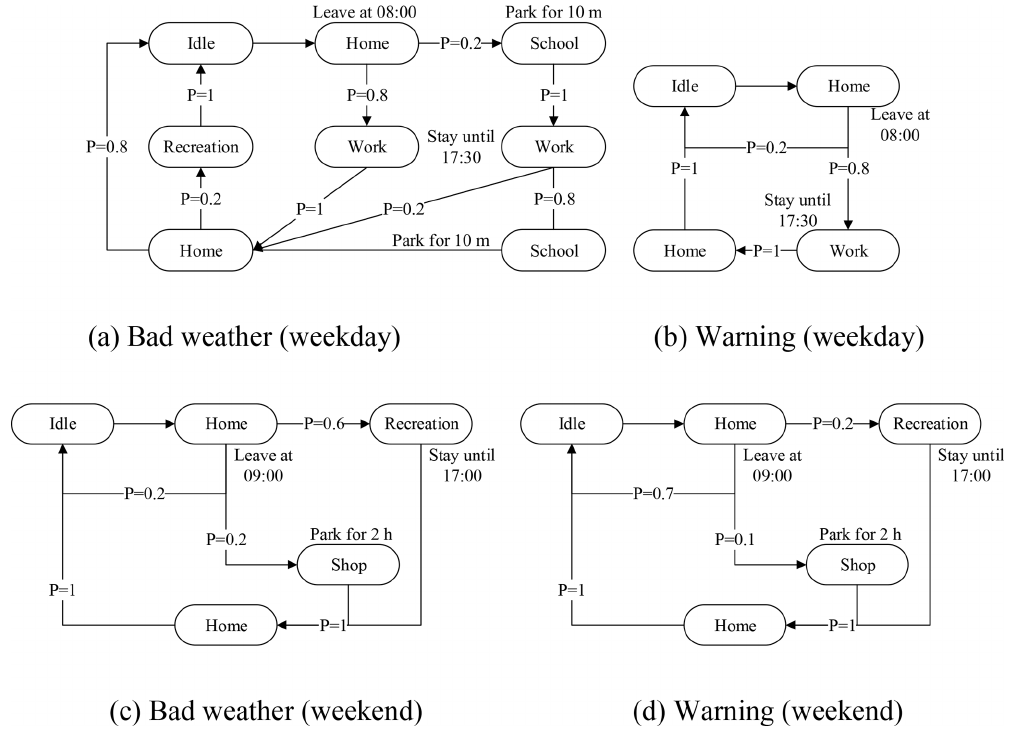
Figure 5. Activity patterns for an employed male agent aged 18–60 years and highly educated during disaster scenarios. (a) Bad weather